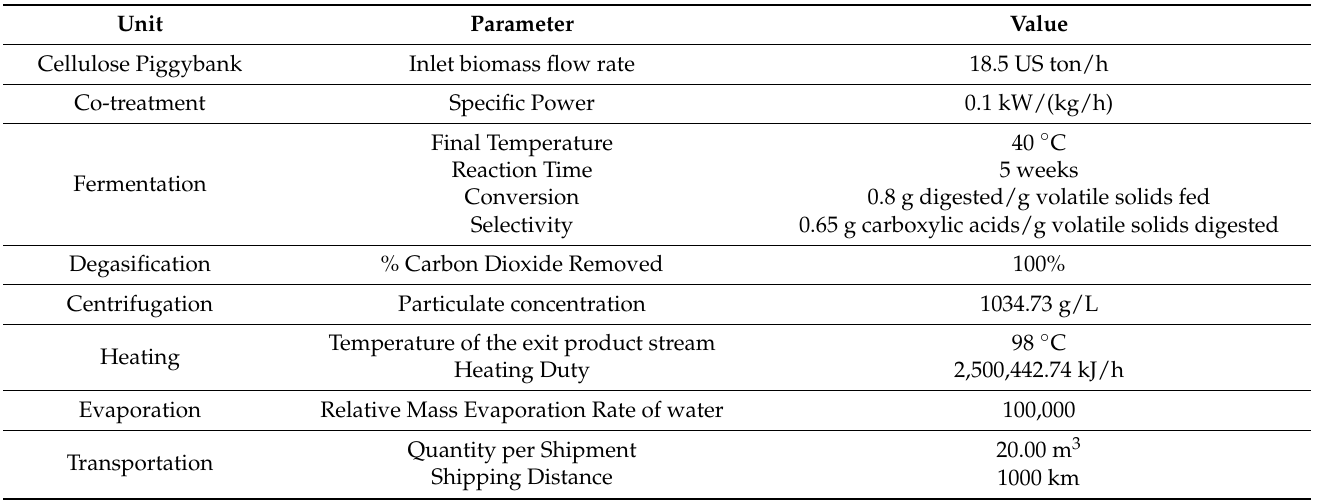
Table 4. Assumptions associated with current process design unit operations.